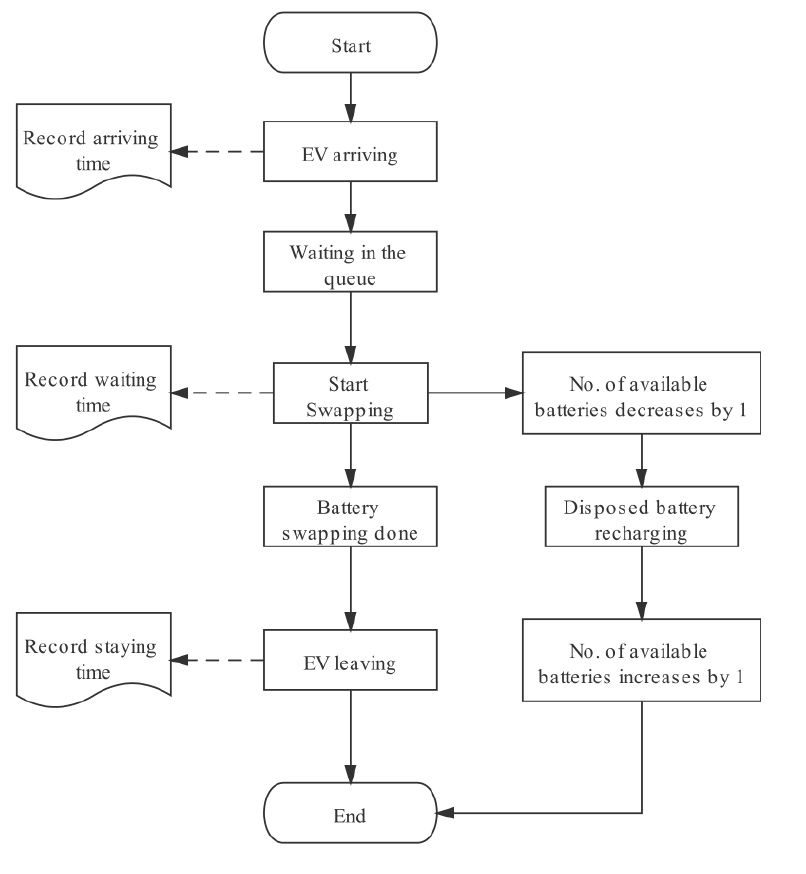
Figure 3. Simulation scenario of varying demand at a single